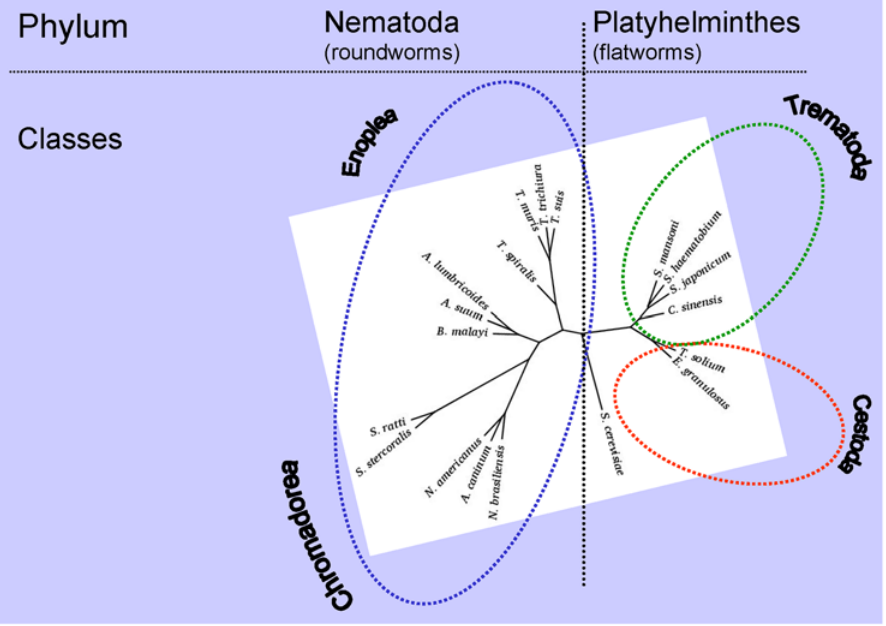
Figure 2. Phylogeny of the major taxa of human helminths—nematodes and platyhelminths—as established by maximum likelihood (ML) analysis of 18S ribosomal RNA from 18 helminth species. Sequences were aligned using ClustalX [93]. The topology of the tree was derived from a consensus tree by neighbor-joining–based bootstrapping, its branch lengths were computed using a ML-based method, and it was rooted with the orthologue from the brewer’s yeast, Saccharomyces cerevisiae . The branch lengths of the phylogenetic tree were computed using DNAML (PHYLIP package [94]) by allowing rate variation among sites. The headings Chromadorea, Enoplea, Trematoda, and Cestoda are major classes of the phyla Nematoda and Platyhelminthes. The GenBank accession numbers of aligned sequences are DQ118536.1 ( Trichuris trichiura ), AY851265.1 ( Trichuris suis ), AF036637.1 ( Trichuris muris ), AY497012.1 ( Trichinella spiralis ), U94366.1 ( Ascaris lumbricoides ), AF036587.1 ( Ascaris suum ), AF036588.1 ( Brugia malayi ), AJ920348.1 ( Necator americanus ), AJ920347.2 ( Ancylostoma caninum ), AF036597.1 ( Nippostrongylus brasiliensis ), X03680.1 ( Caenorhabditis elegans ), AF036605.1 ( Strongyloides ratti ), U81581.1 ( Strongyloides ratti ), AB453329.1 ( Strongyloides ratti ), AF279916.2 ( Strongyloides stercoralis ), AB453315.1 ( Strongyloides stercoralis ), M84229.1 ( Strongyloides stercoralis ), EU011664.1 ( Saccharomyces cerevisiae ), , U27015.1 ( Saccharomyces cerevisiae ), DQ157224.1 ( Taenia solium ), AF229852.1 ( Clonorchis sinensis ), Z11590.1 ( Schistosoma japonicum ), Z11976.1 ( Schistosoma haematobium ), U65657.1 ( Schistosoma mansoni